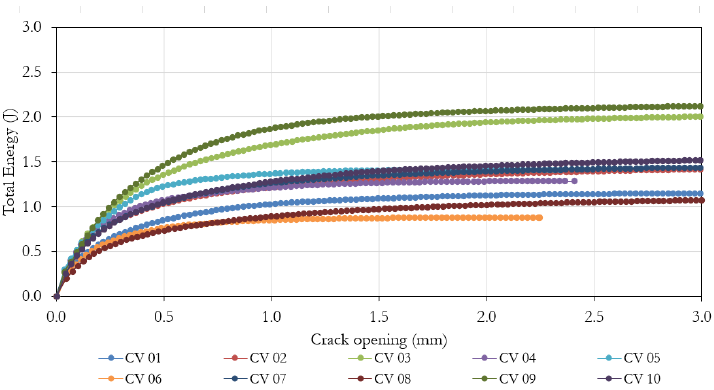
Figure 9. Fracture energy curves for conventional